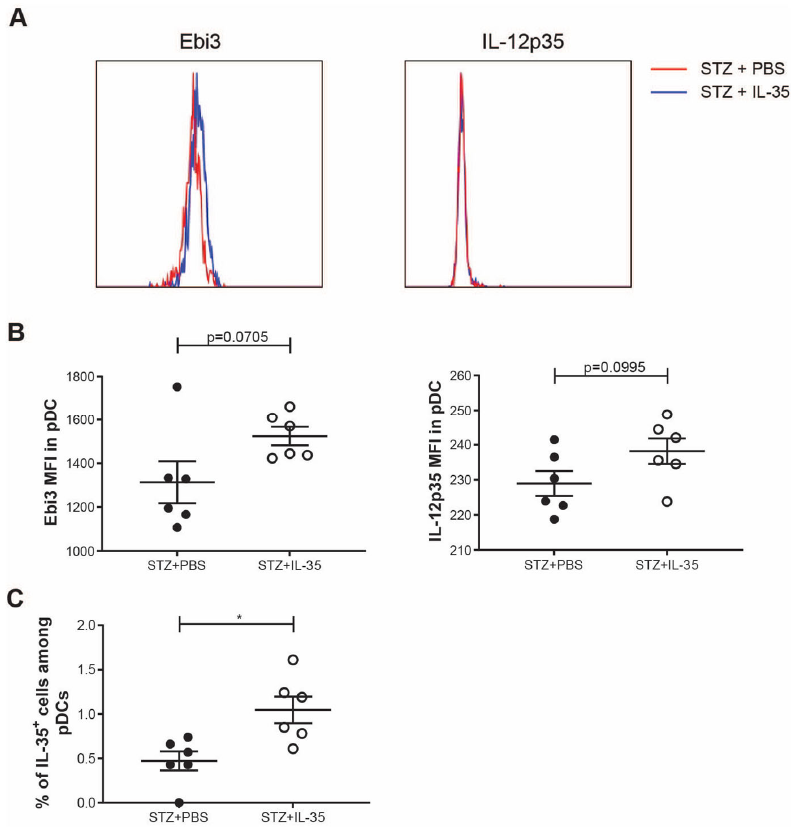
Figure 8. IL-35 expression in pDCs. STZ mice received IL-35 (0.75 µ g per day) or PBS treatment for the following 8 days and were killed on day 14. Single cells from the spleen were prepared. ( A ) The representative histogram of fluorescence of Ebi3 and IL-12p35 in pDCs. ( B ) The MFI of Ebi3 and IL-12p35 in pDCs. ( C ) The proportion of IL-35 + cells among pDCs. Results are expressed as means ± SEM. Unpaired t ‐ tests were performed for comparisons. * denotes p < 0.05.